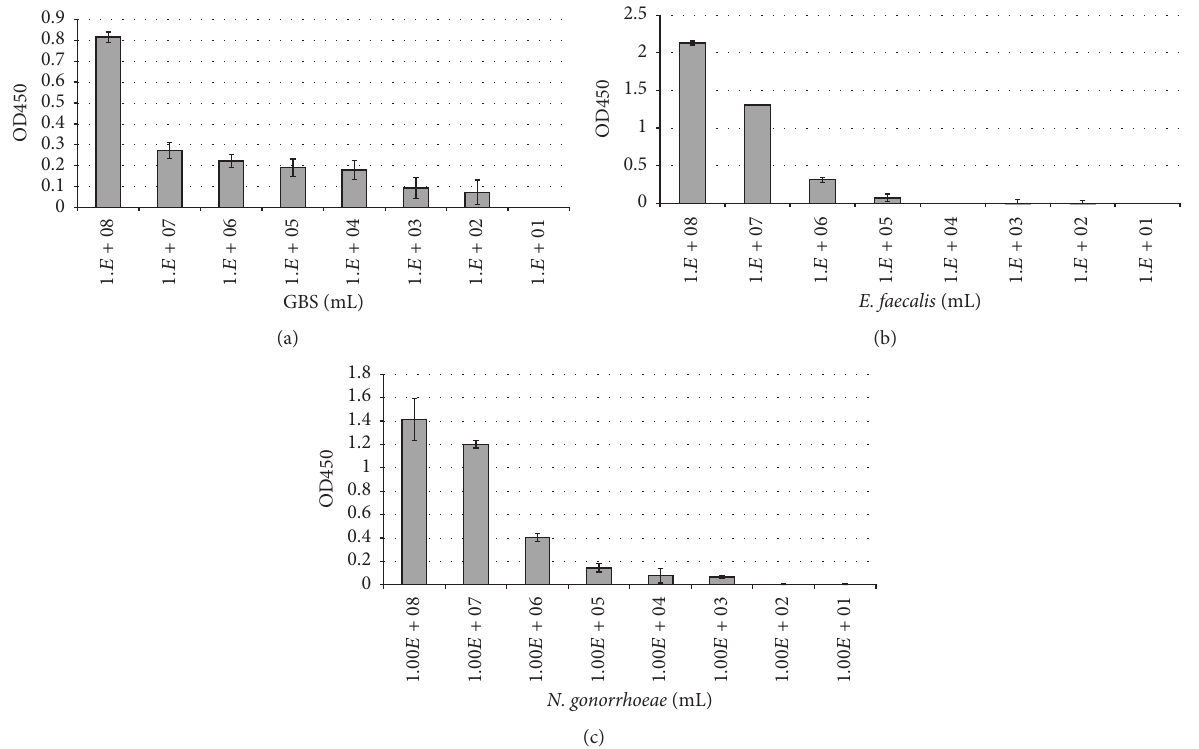
Figure 1: Determination of the limit of detection for the Time Zero Test. GBS (a), Enterococcus (b), and N. gonorrhoeae (c) were prepared at 0.5 McFarland in PBS and diluted out serially. Following 20-minute incubation at room temperature, wells were washed and then HRP- conjugated antibody directed against the bacterium of interest was used to detect any bound organism. Three distinct strains of GBS were tested, two strains of Enterococcus, and N. gonorrhoeae each. Results shown are of GBS clinical isolate 01.12.76 (a), Enterococcus ATCC strain 29212 (b), and N. gonorrhoeae strain 19424 (c); each study was performed in triplicate and representative of three individual experiments. Bacterial concentrations were confirmed by CFUs following plating on agar for 24–48